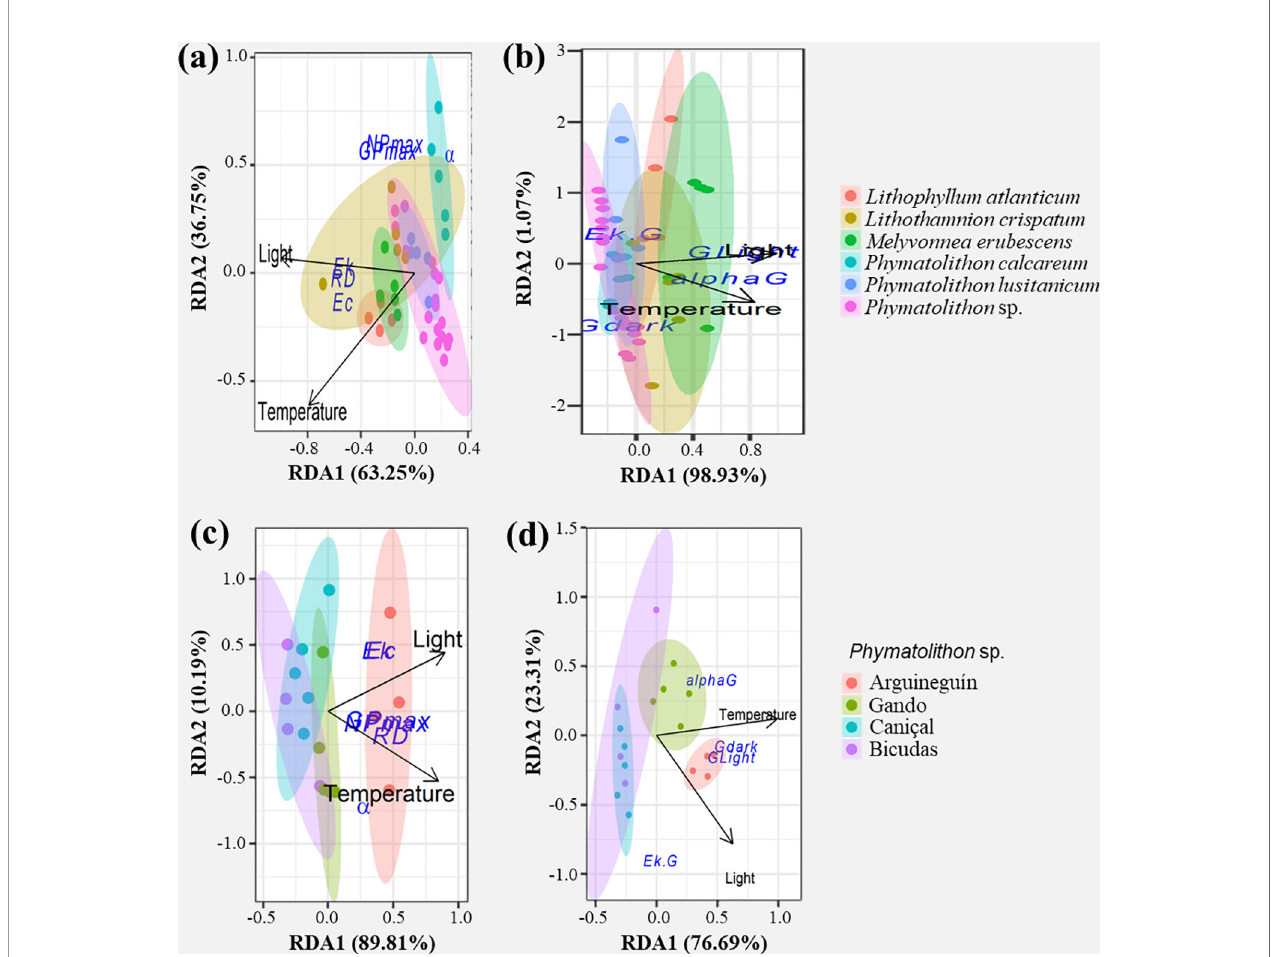
FIGURE 4 | In fl uence of environmental factors on rhodolith physiological performance. Redundancy analysis (RDA) biplots show the contribution of local environmental conditions (light availability, temperature) to the variation in photosynthetic (A, C) and calci fi cation parameters (B, D) of all studied Atlantic rhodolith species (A, B) and of Phymatolithon sp. sampled in different locations (C, D) . Arrows represent correlations between environmental variables and the RDA axes, with arrow length indicating the strength of the correlation. Response variables are indicated by circles (GP max , NP max - max. gross and net photosynthesis; R D - dark respiration; a , alpha G - photosynthetic and calci fi cation ef fi ciency under subsaturating light intensities; E k , E c - saturating and compensatory light intensity; G Light , G dark - max. light and dark calci fi